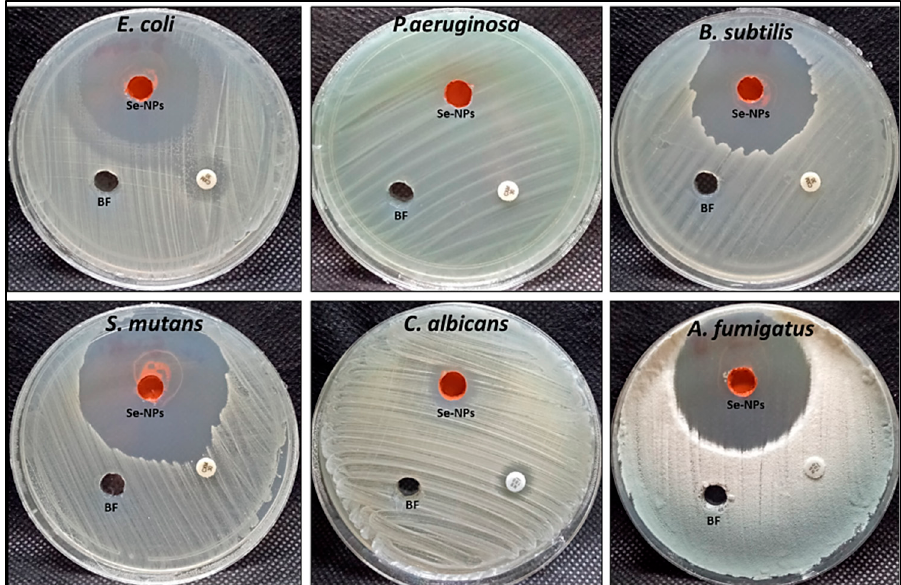
Figure 6. Antimicrobial activity of Hem-NPs using the agar well diffusion method.